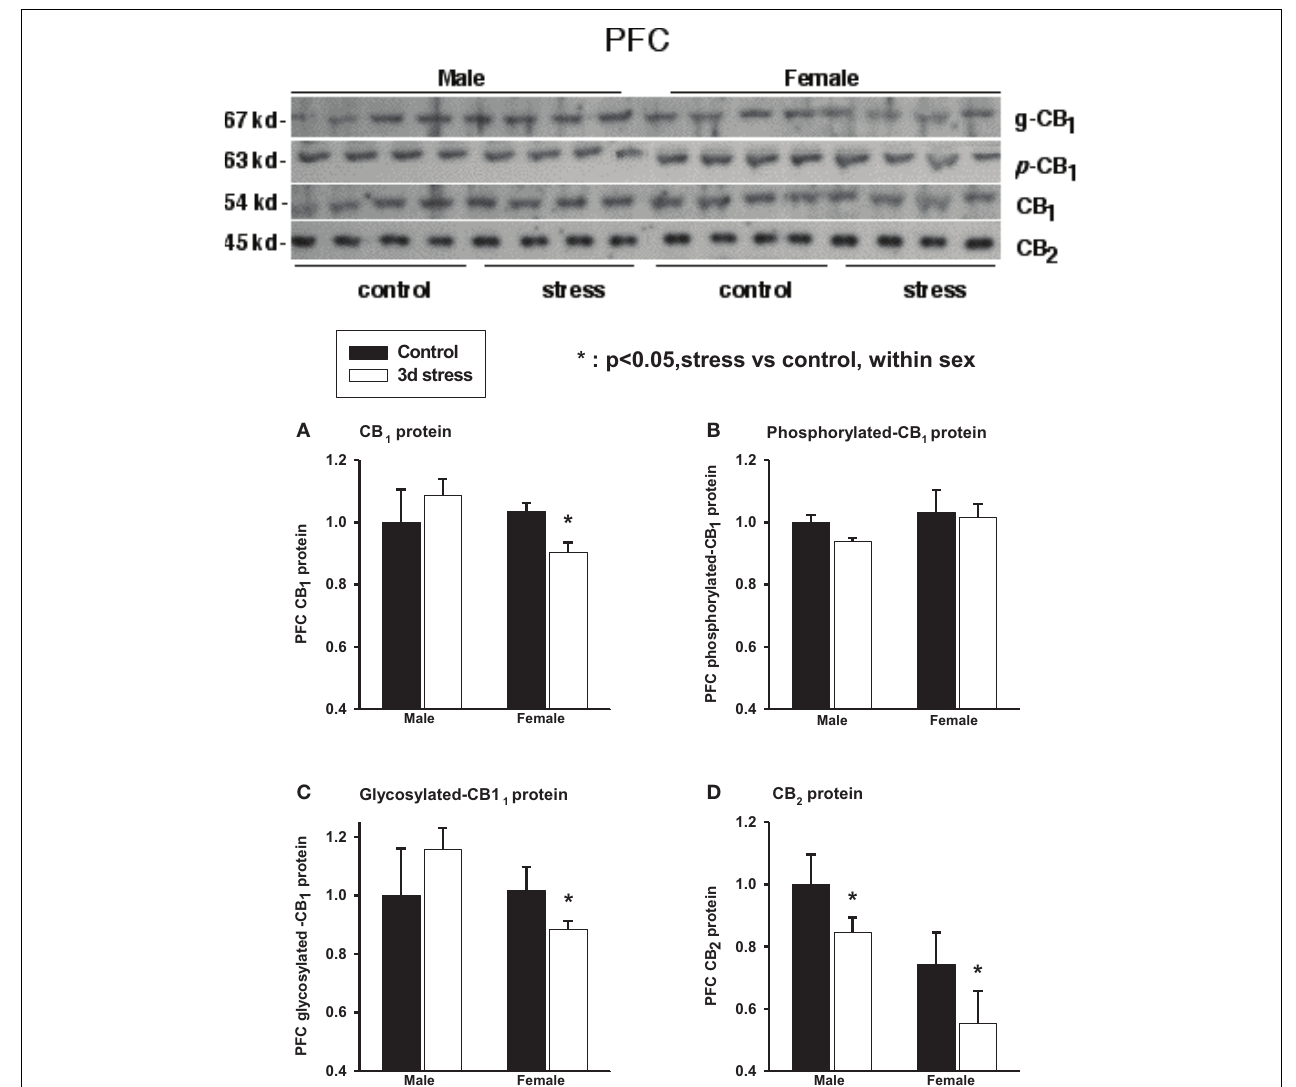
significantly reduced total CB 1 proteins and glycosylated-CB 1 proteins in female prefrontal cortex (mean ± SD); CB 2 protein levels were significantly reduced in the prefrontal cortex of both female and male rats after repeated stress (D) .The mean value of the male control group was used as the arbitrary reference = 1, * p < 0.05, control vs. stress within sex comparison, black column, control group; blank column, stressed